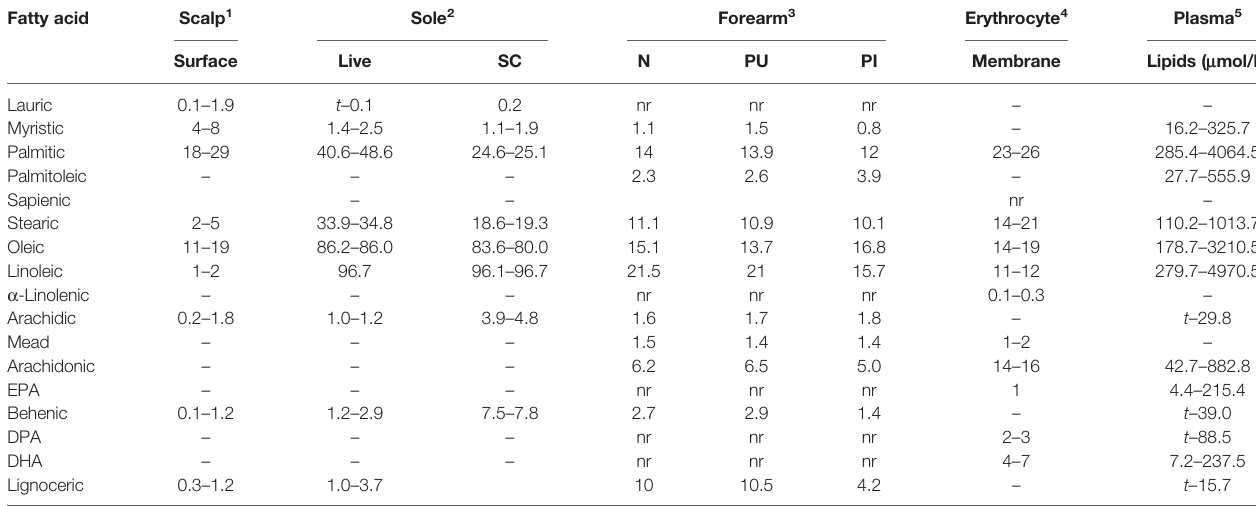
TABLE 2 | Fatty acid composition from various body sites (%).